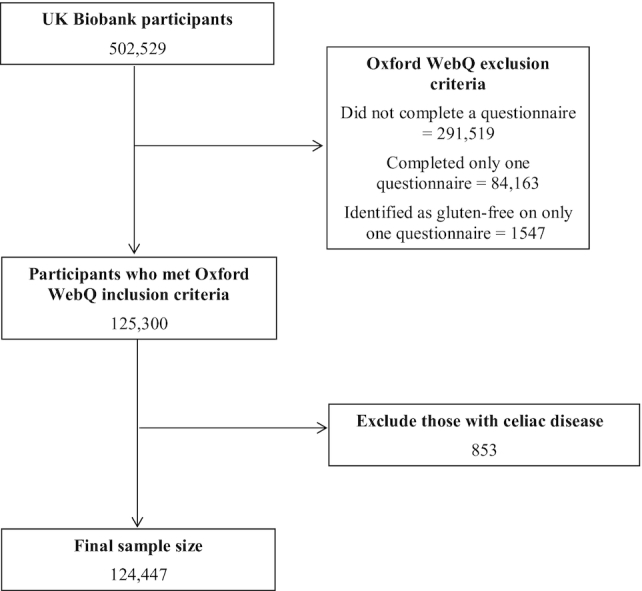
Flowchart for final analytic sample size.